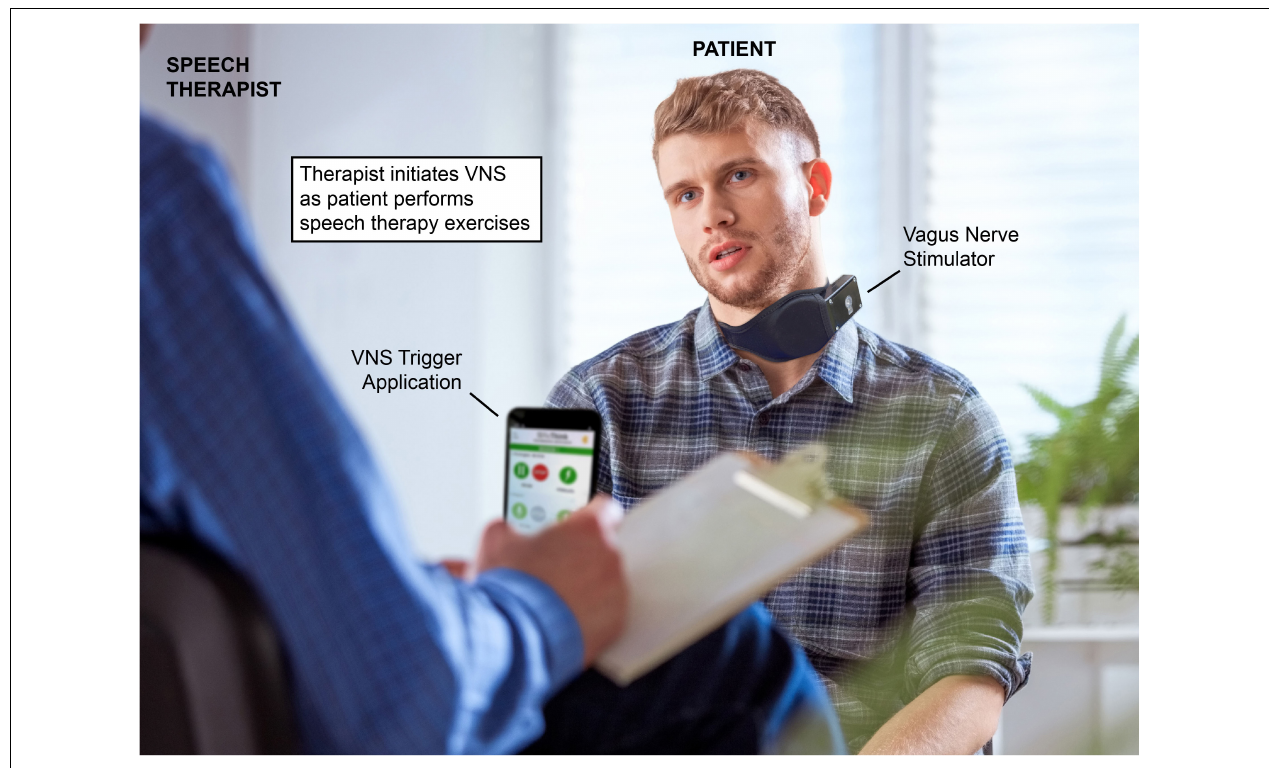
FIGURE 1 | Example of vagus nerve stimulation (VNS) paired speech therapy. A patient with a VNS implant performs speech therapy exercises. The speech therapist initiates VNS via a mobile application at moments the therapist deems conducive to the patient’s recovery. The mobile device used by the therapist activates the power control module, which wirelessly powers the implanted vagal nerve cuff. Reproduced with permission from